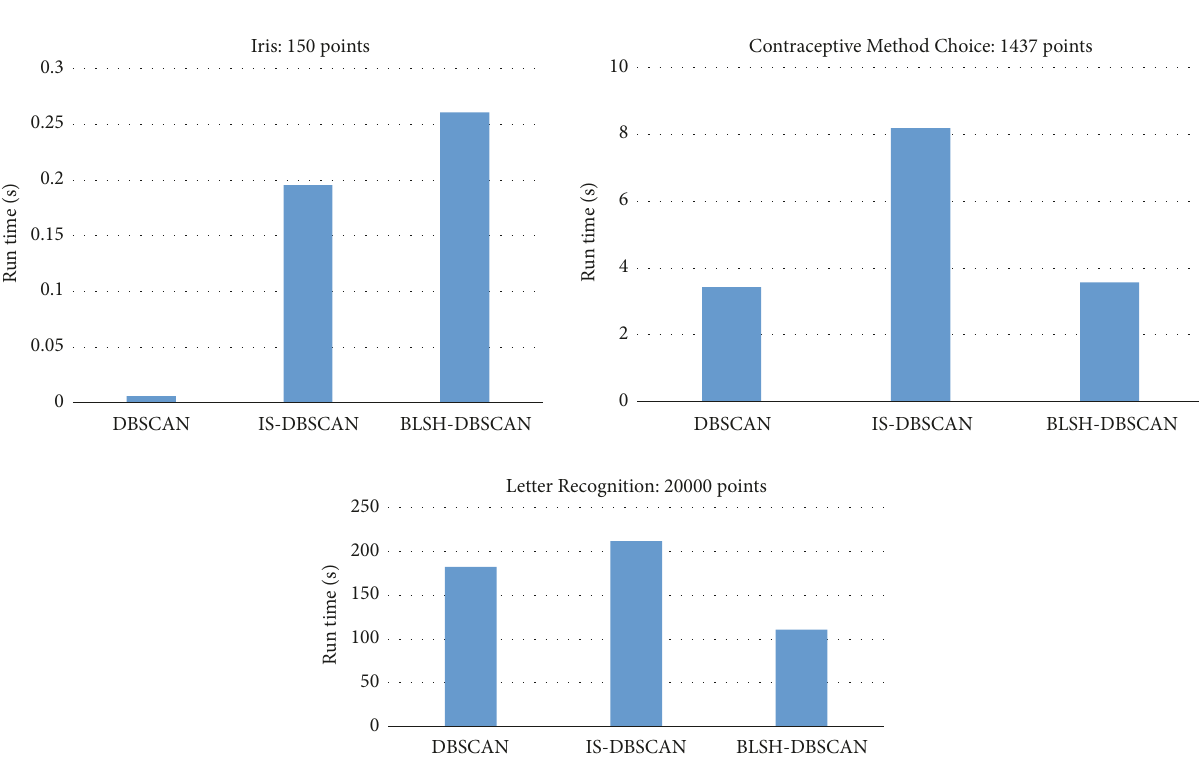
Figure 5: Comparison of run time of the DBSCAN, IS-DBSCAN, and